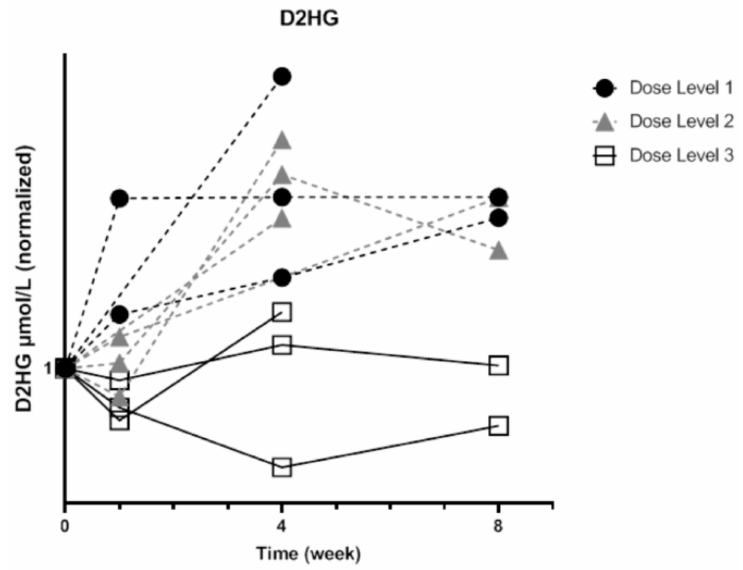
Figure 6. Serial D -2HG serum concentrations of patients treated with dose levels 1, 2 and 3. D -2HG serum concentrations were increased with time in dose levels 1 and 2 (not significant, respectively p = 0.1 and p = 0.23, Kruskal–Wallis test), whereas with dose level 3, stable or lower D -2HG serum concentrations were found (Not significant, p = 0.1, one-way ANOVA